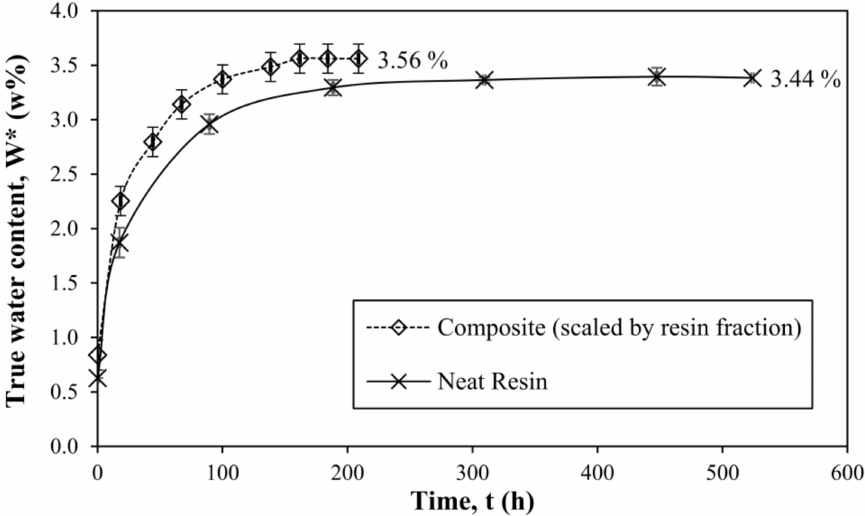
Figure 5. True water content curves of neat resin and glass fiber-reinforced composite (scaled by the resin mass